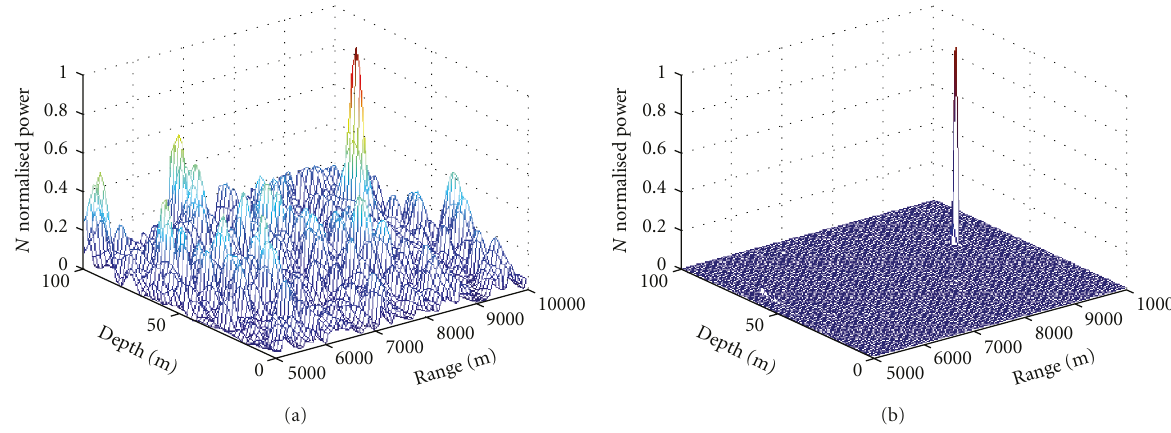
Figure 2: Bartlett ambiguity surface for COLNOISE with SNR of (a) and EMD-MFP ambiguity surface (b) for COLNOISE (SNR = 10dB).